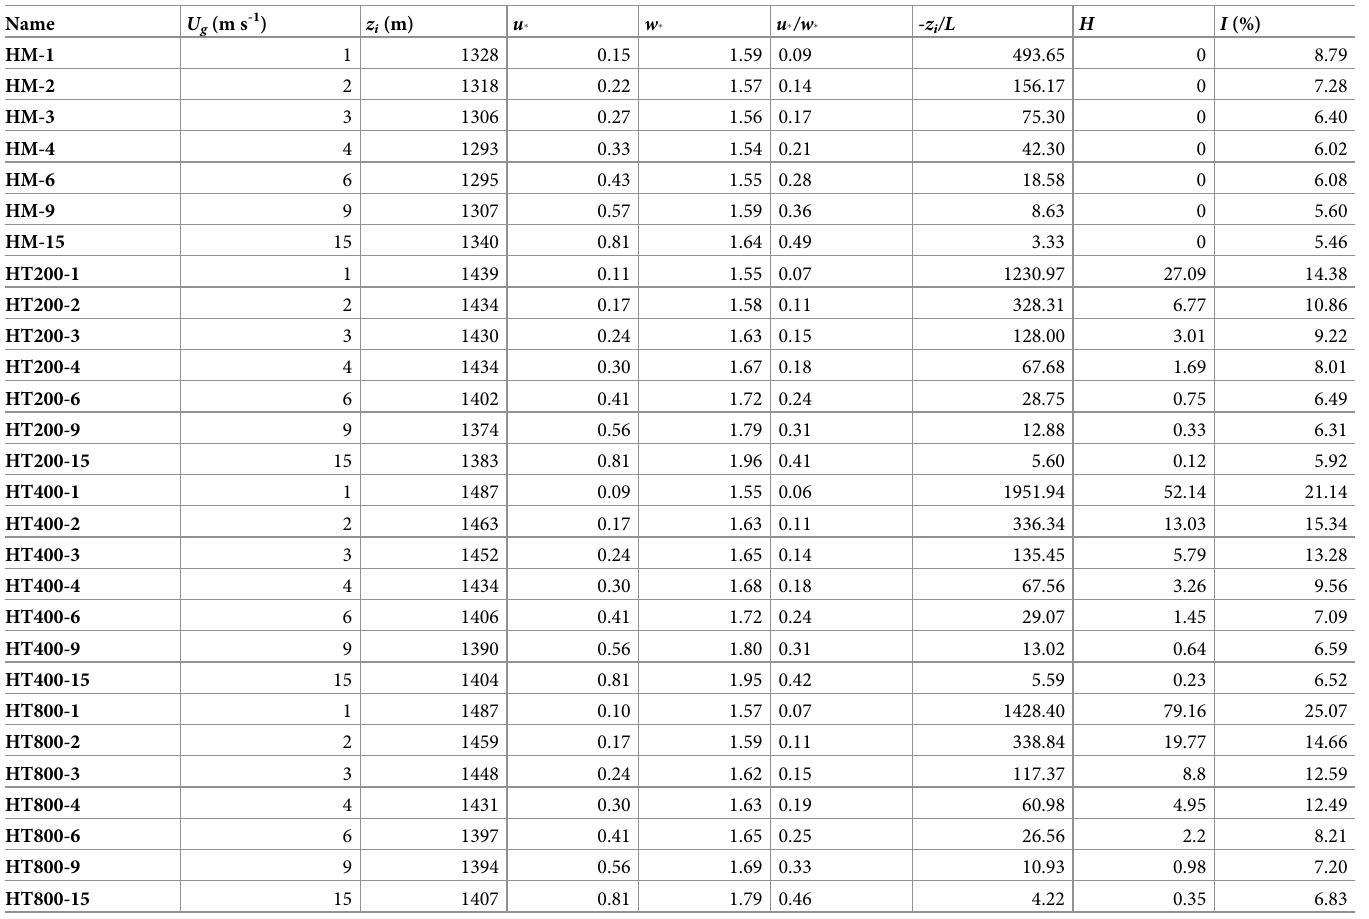
Table 2. Overview over characteristic variables that are relevant for this study, including geostrophic wind speed U g , boundary layer height z i , the friction velocity u � , the Deardorff velocity w � , the atmospheric stability parameters u � /w � and - z i /L , the heterogeneity parameter H , and the energy imbalance I for each